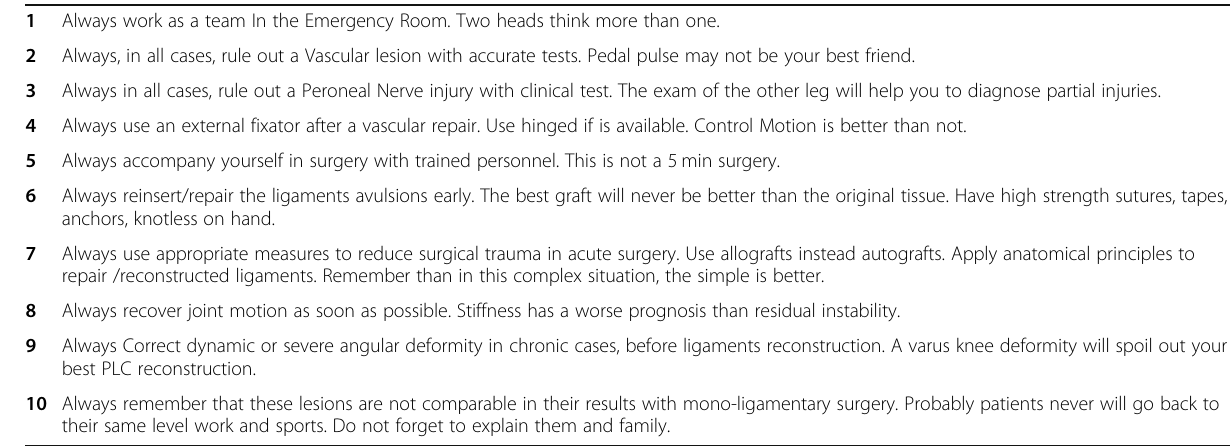
Table 1 The 10 recommendations for the Orthopedist dealing with the Treatment of Acute MLKI Injuries Always work as a team In the Emergency Room. Two heads think more than